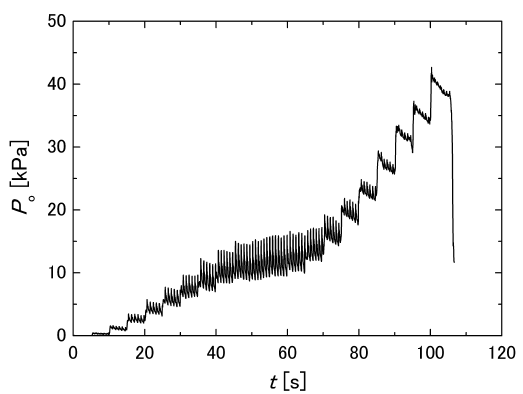
Fig. 1 Experimental setup for measurement of pulse waves (11) .